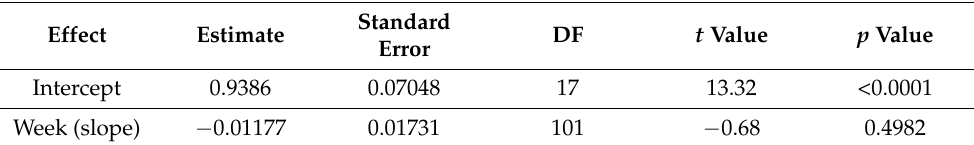
Table 3. Changes in 3,5-T2 and 3-T1AM over time in the patients with hypothyroidism treated with LT3. Weekly Sampling of 3,5-T2